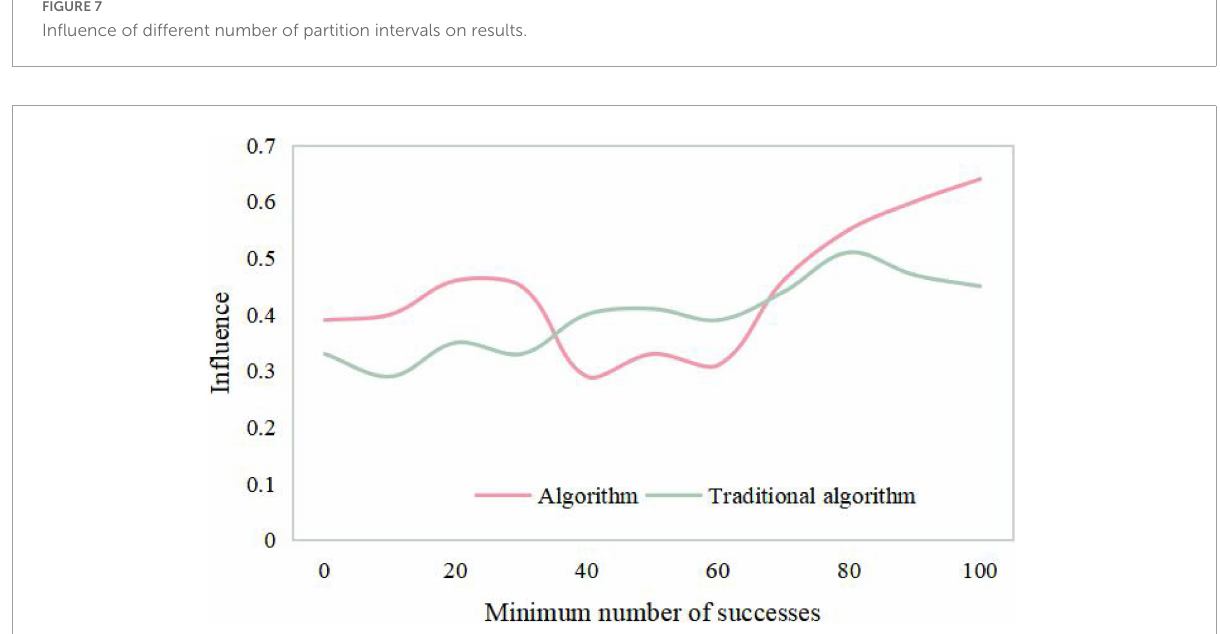
FIGURE8 Curve diagram of the influence of different minimum success numbers on the